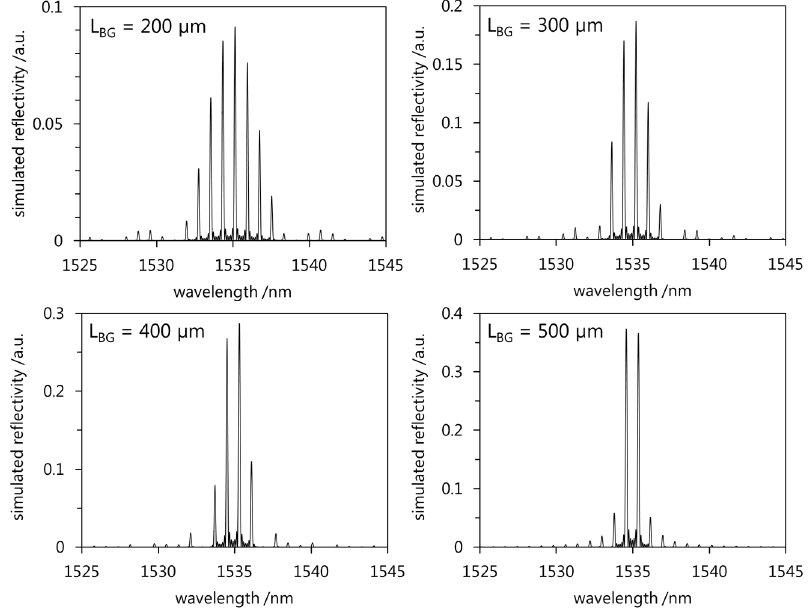
Figure 2. Simulated reflected spectra of superstructure Bragg gratings with the same superstructure period ( P = 1 mm) and different L BG .